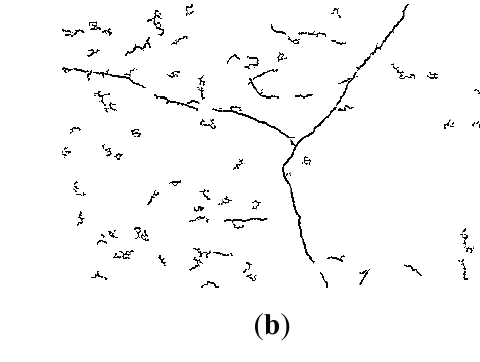
=3, (cid:1840) =350; ( e ) ( f ) (cid:1872) (cid:3028) (cid:3003)